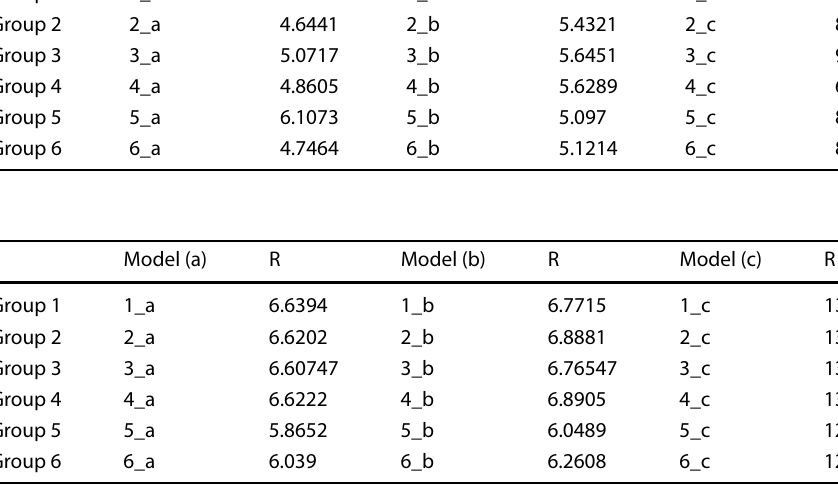
Table 5 The response modification factors of 4-story 3-span structure